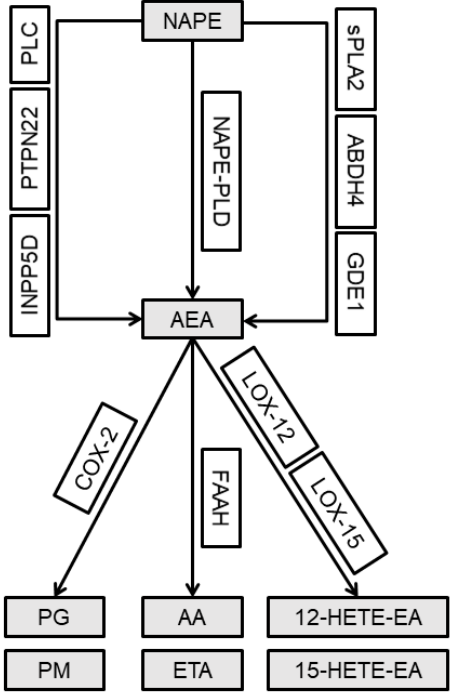
Figure 1. Simplified diagram of anandamide synthesis and degradation pathways. See text for details.